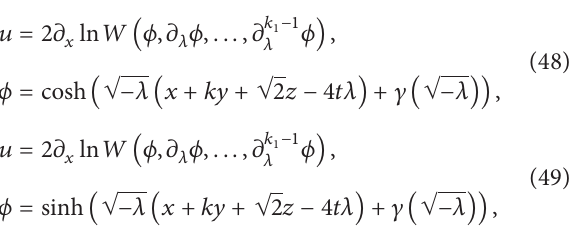
where 𝜃 𝑖 = √−𝜆 𝑖 (𝑥+𝑘𝑦+√2𝑧−4𝑡𝜆 𝑖 )+𝛾 𝑖 , 𝑖 = 1, 2 . Figures 1 and 2 of three-dimensional plots show the 𝑛 -soliton to (1) defined by (40) on the indicated specific regions, with specific values being chosen for the parameters.